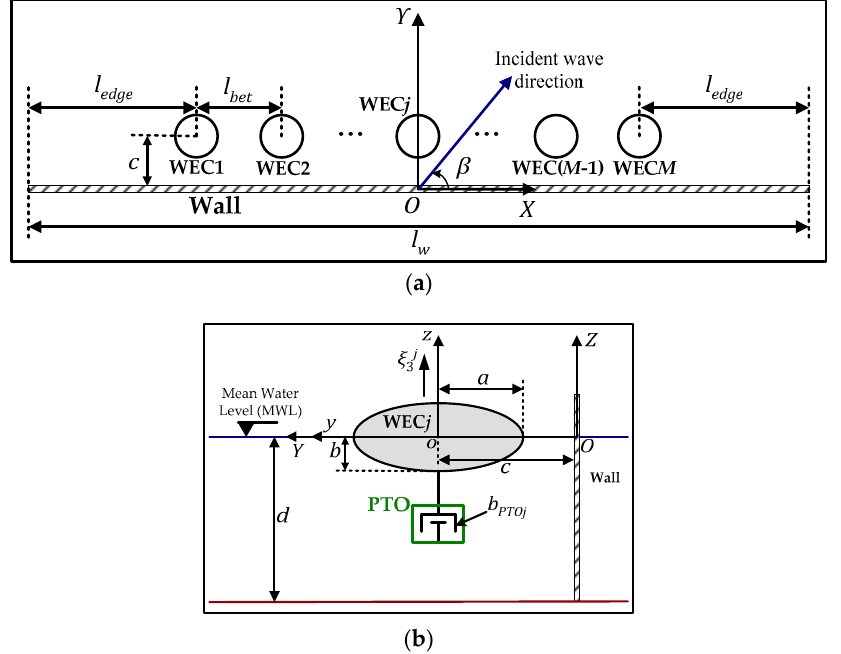
Figure 1. Geometry of the investigated arrangement and definition of basic quantities: ( a ) X-Y plane and ( b ) Y-Z plane.